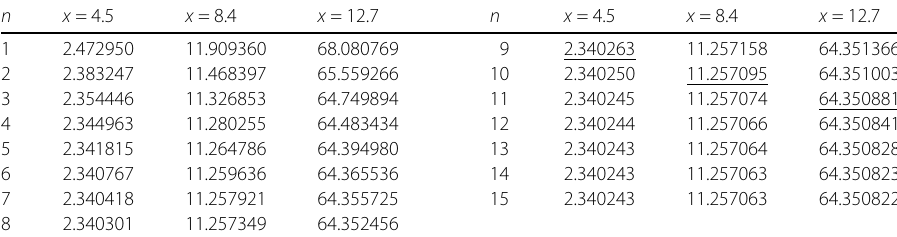
Table 1 Some numerical results for calculation of Γ q ( x ) with q = 1 and n = 1,2, ... ,15 of Algorithm